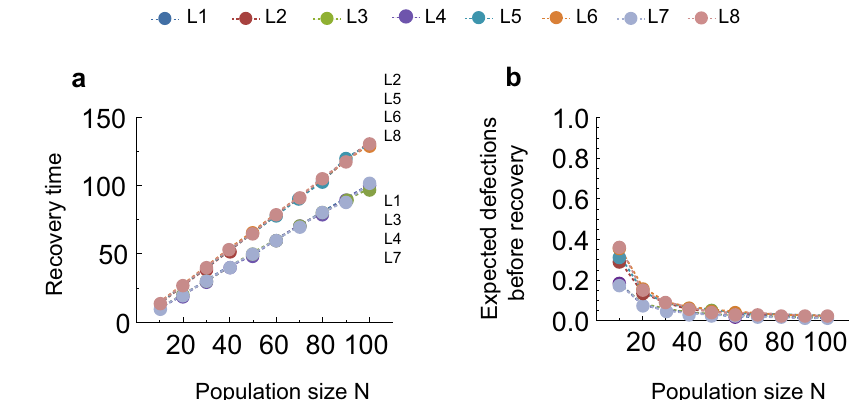
Fig.4|Actualrecoverytimes. Wesimulatetherecoveryfromthestate(0, N − 2,0) toastatewith s ∈ {0,1}and k + l = N − 1bysimulatingthereputationdynamics. a We fi ndthattherecoverytimeforallleadingeightnormsislinearinpopulationsizeN. For L 1 , L 3 , L 4 , L 7 , the slope of the curve is ~1, whereas the slope is ~1.3 for the